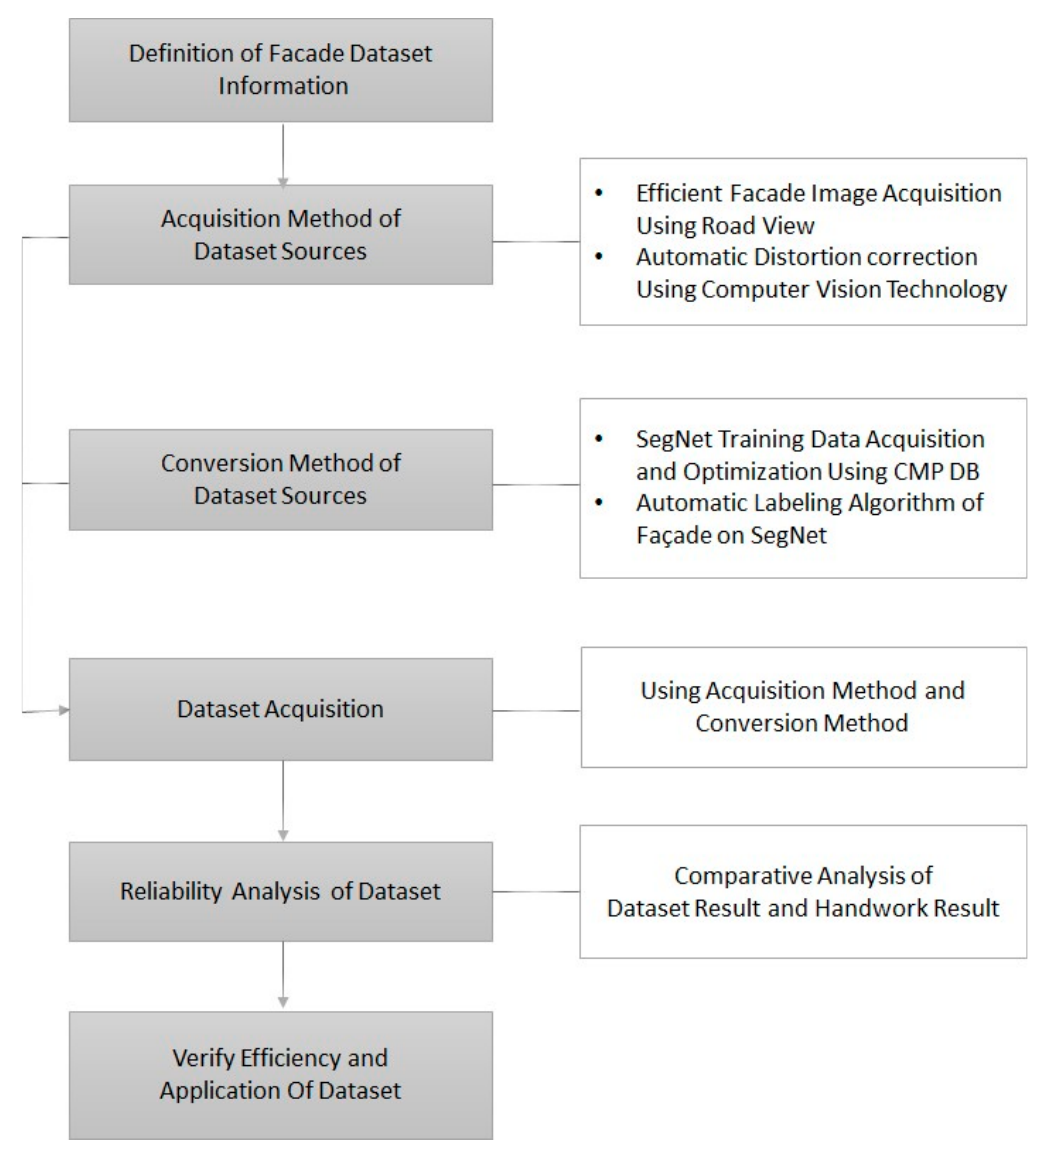
Figure 2. Research direction.